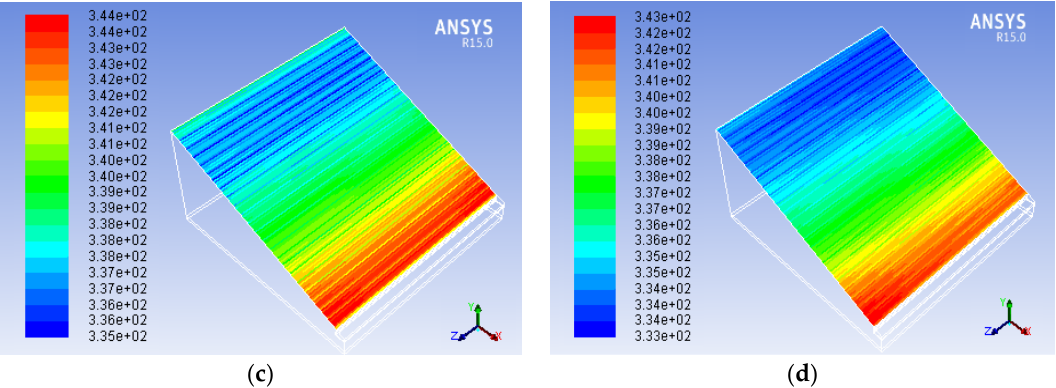
Figure 10. The temperature contours of the glass cover at di ff erent time intervals with a water depth of 2 cm. ( a ) Contour of temperature at 10:00, ( b ) contour of temperature at 12:00, ( c ) contour of temperature at 14:00, ( d ) contour of temperature at 16:00.